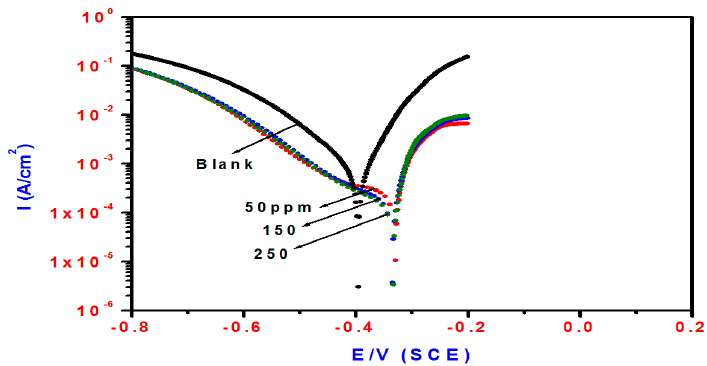
Figure 4. The effect of T3EA concentrations on the polarization curves of steel in acidic chloride solutions. Table 1. The effect of T3Q, T3EA and T3AMPY concentrations on the IE% values for steel in acidic chloride solutions using electrochemical